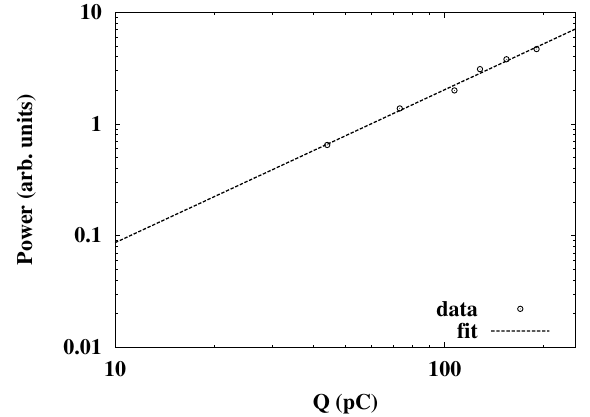
FIG. 7. Dependence of bolometer signal versus bunch charge. The circles are measurement, the line is a fit of the measure- ment using a (cid:15) (cid:13) Q (cid:12) law, the result gives (cid:12) (cid:3) 1 : 37 (cid:14) 0 : 06